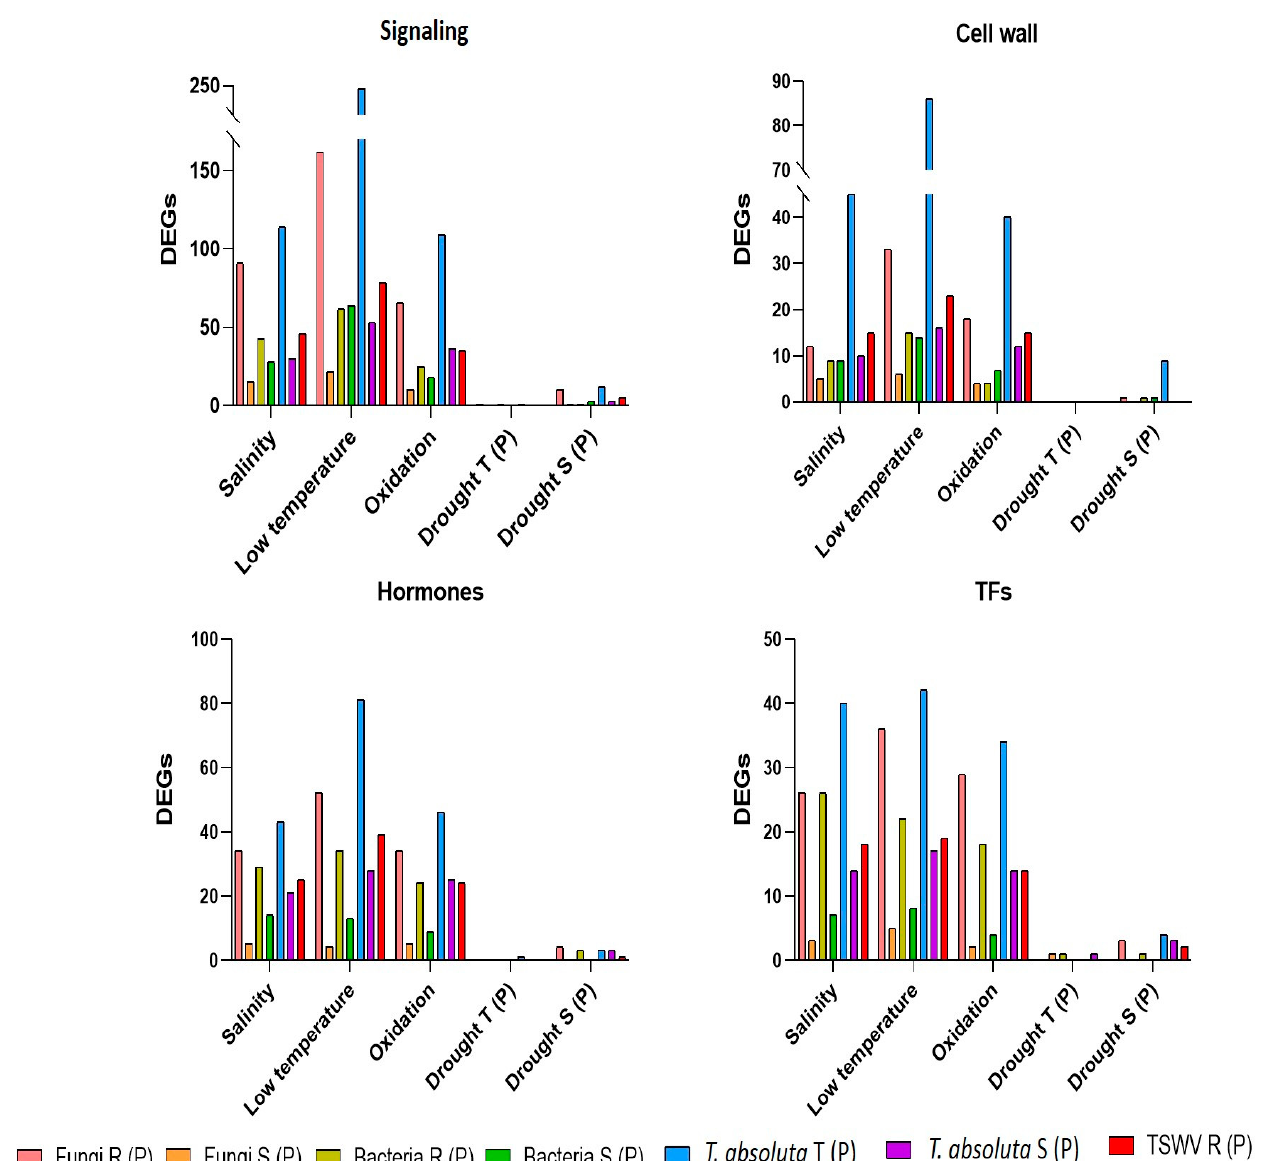
Figure 8. Common DEGs in biotic and abiotic stress related to signaling, cell wall, hormones and transcription factors (TFs). (P) = private DEGs; R = resistant genotype; S = susceptible genotypes; T = tolerant genotype.